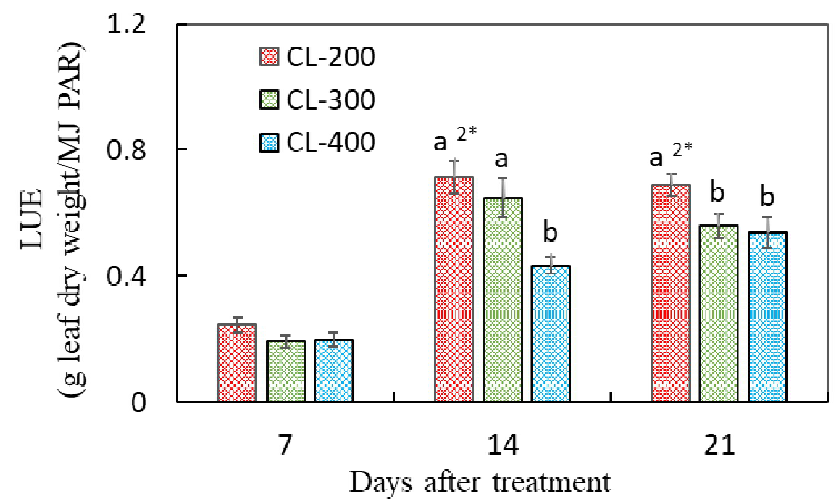
Figure 6. Light use efficiencies (LUE) of nasturtium grown under CL-200, CL-300, and CL-400 at 7, 14, and 21 days after treatment. Values are the means ± SE ( n = 8). Different alphabet letters indicate significant differences between the treatments, the signs 2 * put after the alphabet ‘a’ at the largest mean for each ‘days after treatment’, indicating that the probability of the ANOVA (the multiple mean comparison by Tukey) was p < 0.01.